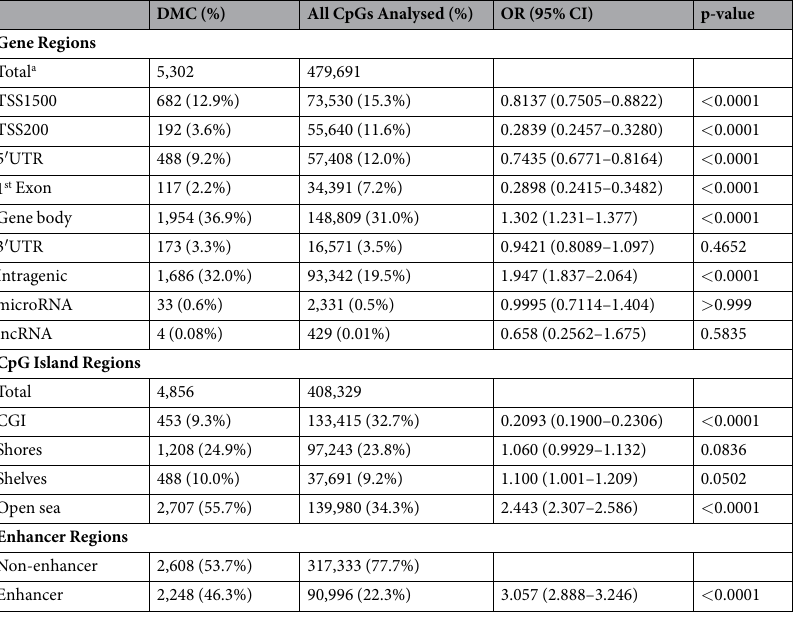
Table 1. The proportion of all CpGs analysed and differentially methylated cytosines (DMC) in each annotated region. a Probes may annotate to more than one gene